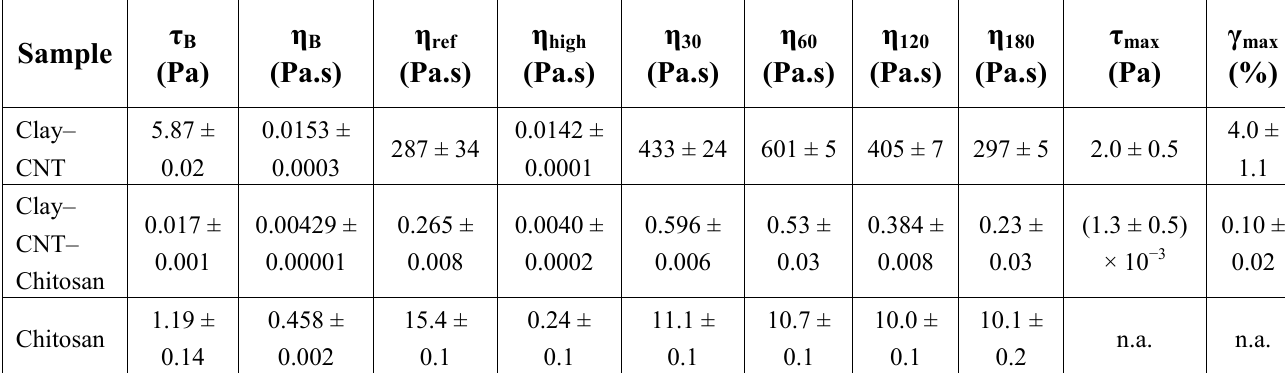
Table 1. Summary of rheology analysis of typical clay–CNT